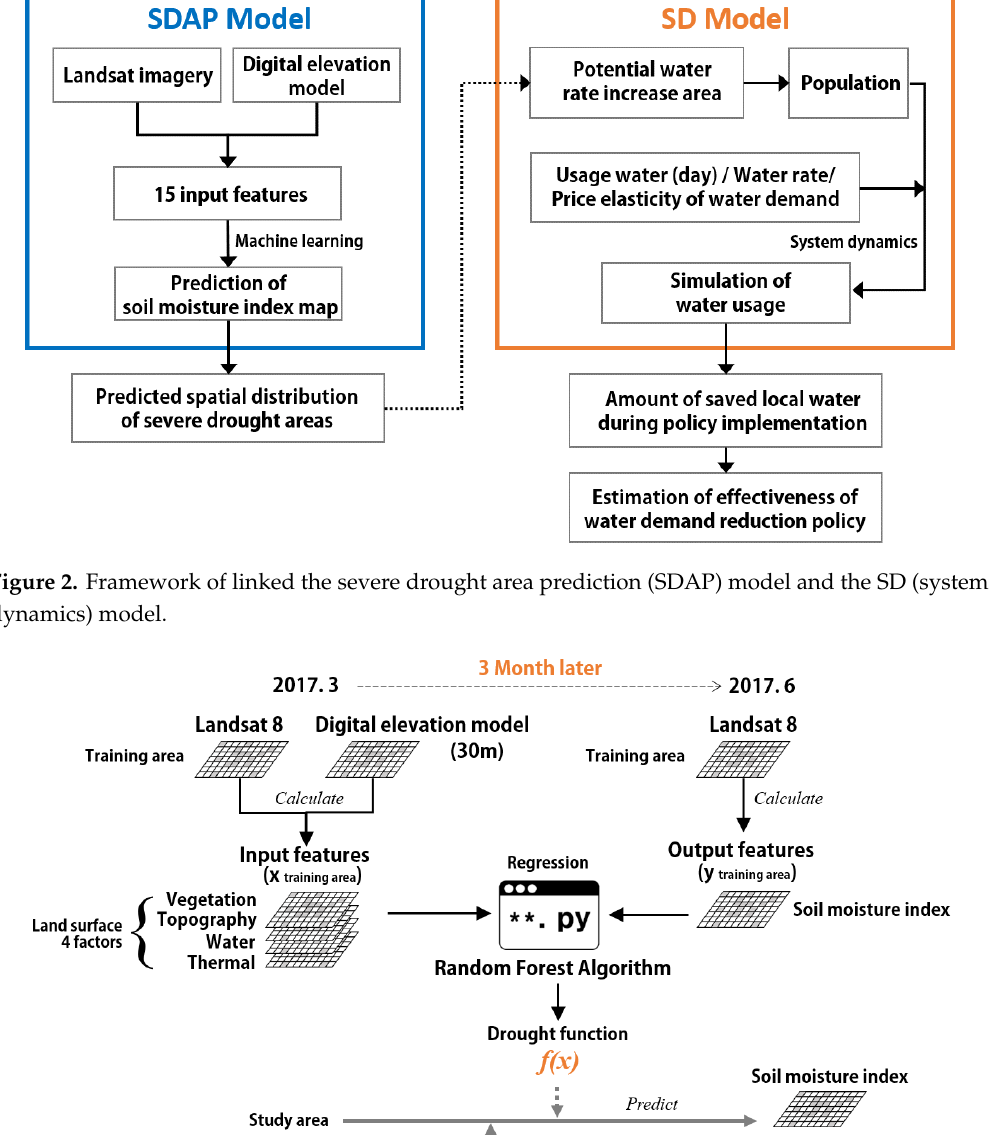
Figure 3. Structure of the SDAP Model.